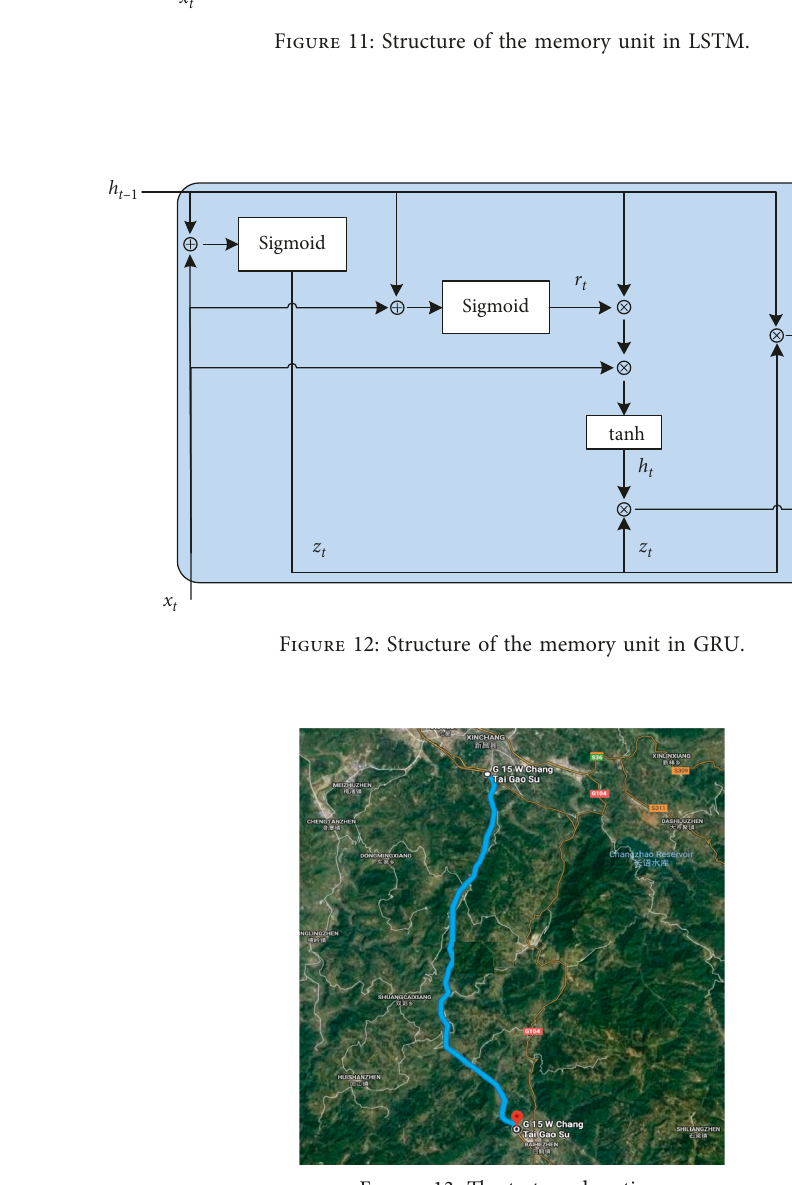
Figure 13: The test road section.